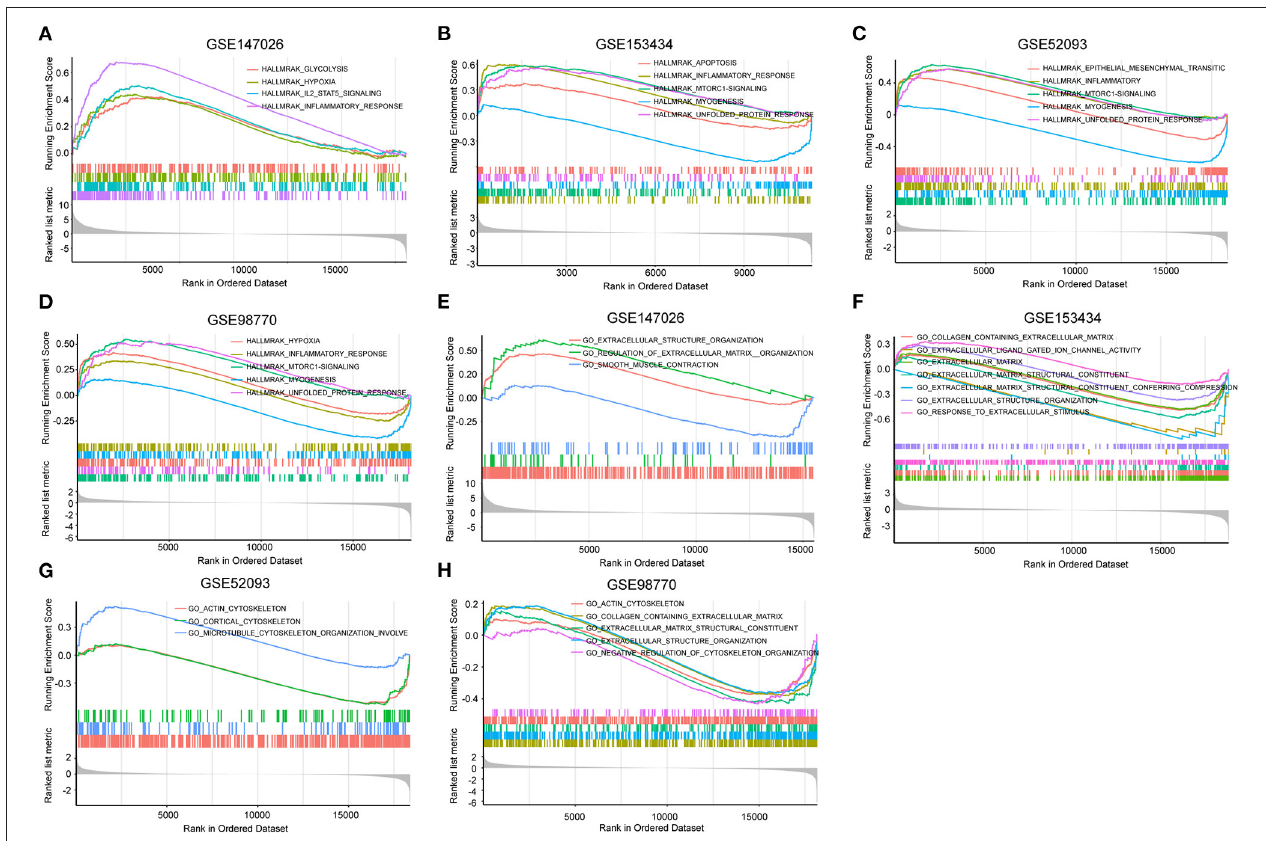
FIGURE 2 | Gene set enrichment analysis (GSEA) was performed to identify gene networks associated with AD. (A–D) Visualization of remarkable enrichment hallmark terms among the four GEO datasets GSE147026, GSE153434, GSE52093, and GSE98770. (E–H) Visualization of remarkablely enriched C5 collection terms among the four GEO datasets GSE147026, GSE153434, GSE52093, and